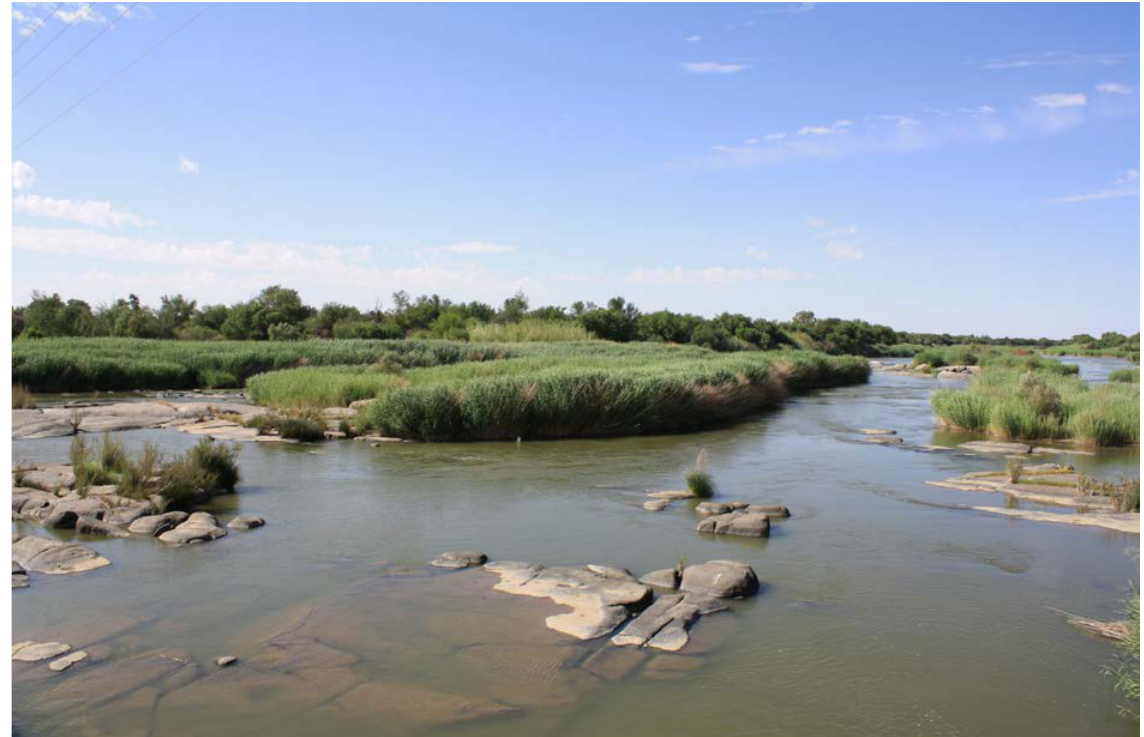
Illustration 2: The Orange River is South Africa’s largest river, carrying 22% of the country’s total river flow.